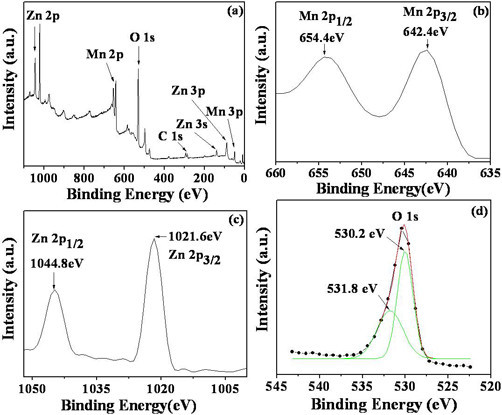
XPS spectra of the ZnMn2O4 nanorods obtained by calcining the precursor at 650°C: (a) survey of the sample; (b) Mn 2p; (c) Zn 2p; and (d) O 1s.